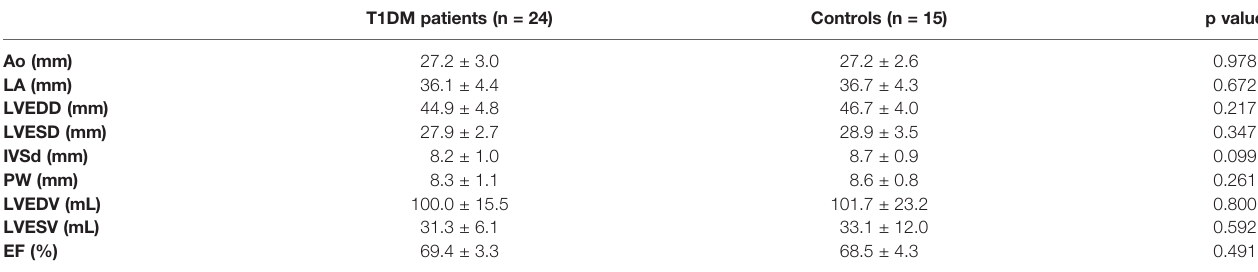
TABLE 3 | Echocardiographic parameters of the study groups.